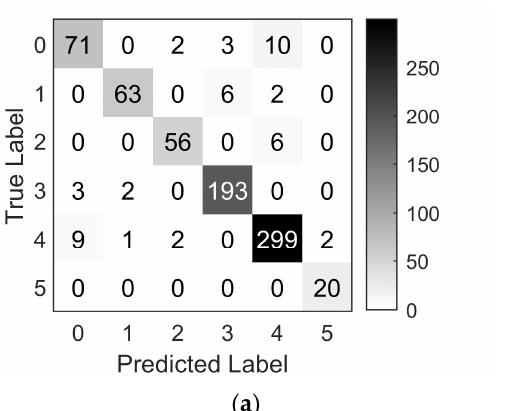
Table 13. The average time consumption of feature extraction per image for the self-built